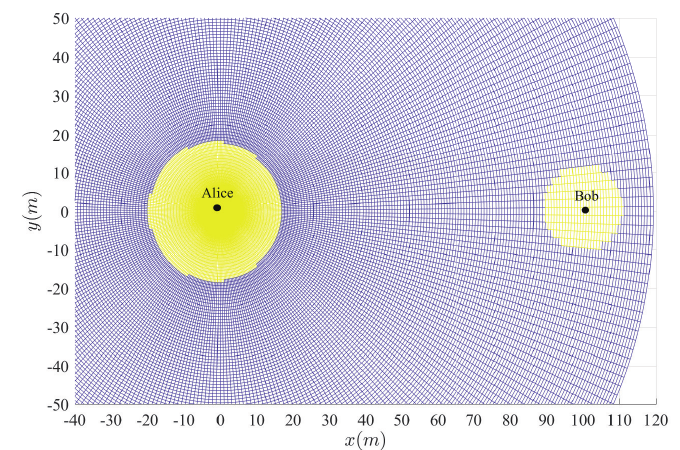
Figure 5. Insecure region with P th e = 20 dBm, N a = 4 and ρ = 10 − 8